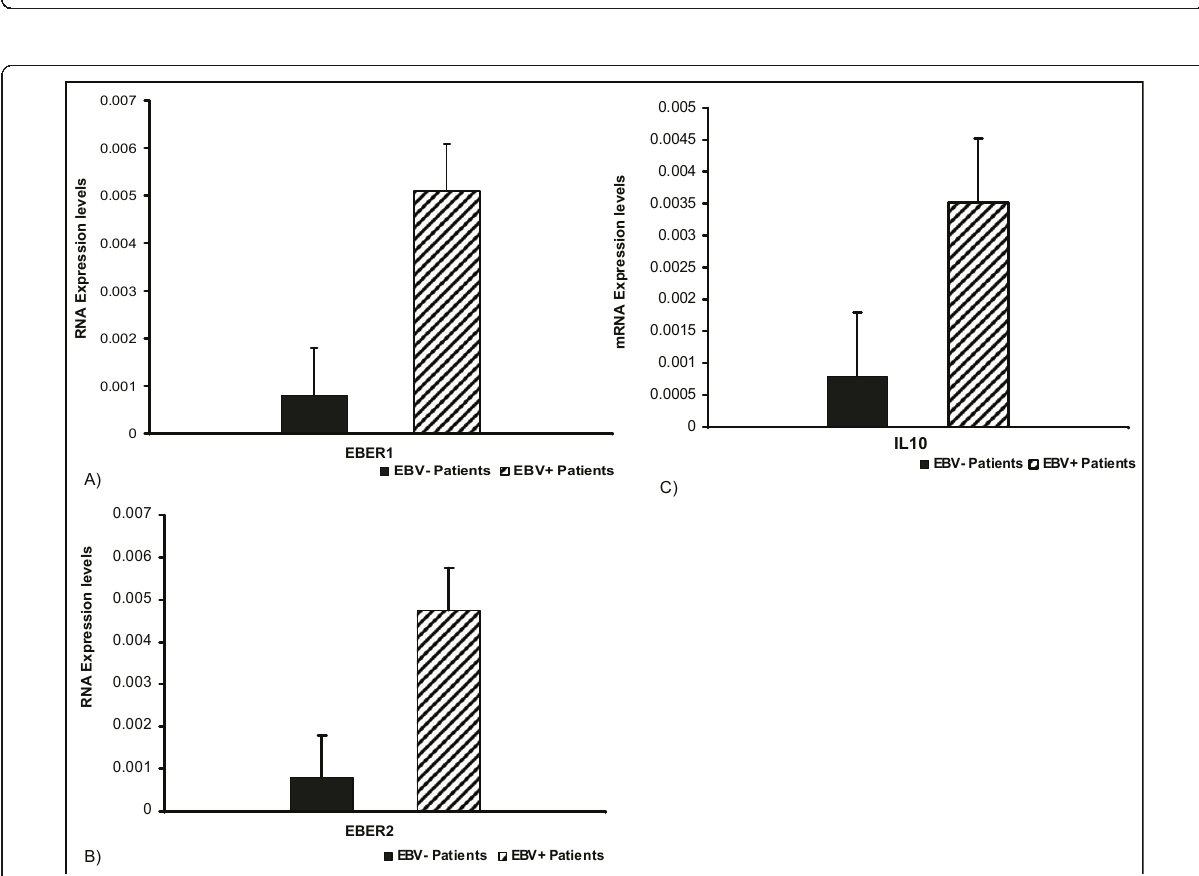
Figure 3 Electropherogram showing semi-quantitative RT-PCR based analysis of EBER1 and EBER2 (left-to-right) : Lane 1 (100 bp ladder), Lane 2 transcript of EBER1 (166 bp), Lane 3 transcript of EBER2 (172 bp), Lane 4 50 bp ladder. All samples were normalized with GAPDH as reference genes.